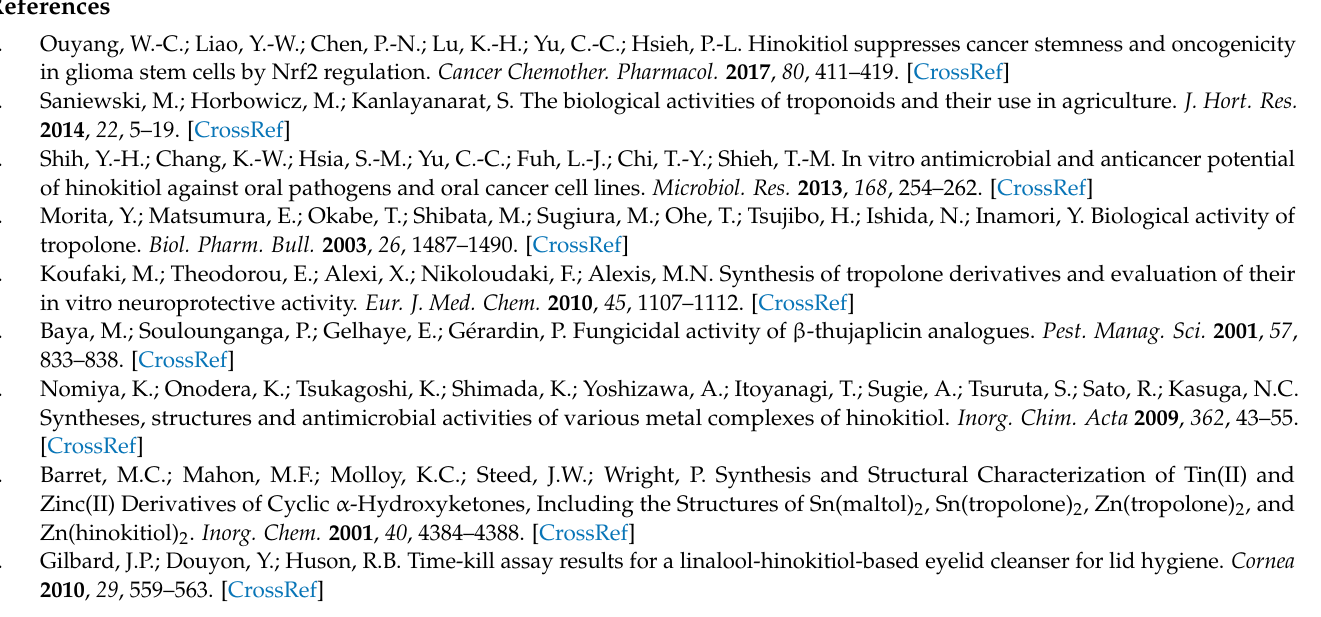
ATR-FTIR of Tl(OTf) · Htrop adduct; Figure S3: ATR-FTIR of Htrop; Figure S4: ATR-FTIR of Tl(trop) ( 1 ); Figure S5: ATR-FTIR of 5-meHtrop; Figure S6: ATR-FTIR of Tl(5-metrop) ( 2 ); Figure S7: ATR-FTIR of Hhino; Figure S8: ATR-FTIR of Tl(hino) ( 3 ); Figure S9: ATR-FTIR of {Tl@[Tl(hino)] 6 }(OTf) ( 4 ); Figure S10: Experimental UV–vis absorption spectra of the studied thallium(I) complexes (red lines) in comparison with the respective ligand (black lines) measured in MeOH solutions; Figure S11: Excitation and emission spectra for complexes 2 – 5 in methanol (left) and the solid state (right); Figure S12: 13 C NMR spectrum of Tl(OTf); Figure S13: (a) 1 H NMR, (b) 13 C NMR, and (c) 19 F NMR spectra of Tl(OTf) · Htrop adduct; Figure S14: (a) 1 H NMR and (b) 13 C NMR spectra of Tl(trop) ( 1 ); Figure S15: (a) 1 H NMR and (b) 13 C NMR spectra of Tl(5-metrop) ( 2 ); Figure S16: (a) 1 H NMR and (b) 13 C NMR spectra of Tl(hino) ( 3 ); Figure S17: (a) 1 H NMR, (b) 13 C NMR, and (c) 19 F NMR spectra of {Tl@[Tl(hino)] 6 }(OTf) ( 4 ); Figure S18: 205 Tl NMR spectra of studied thallium(I)